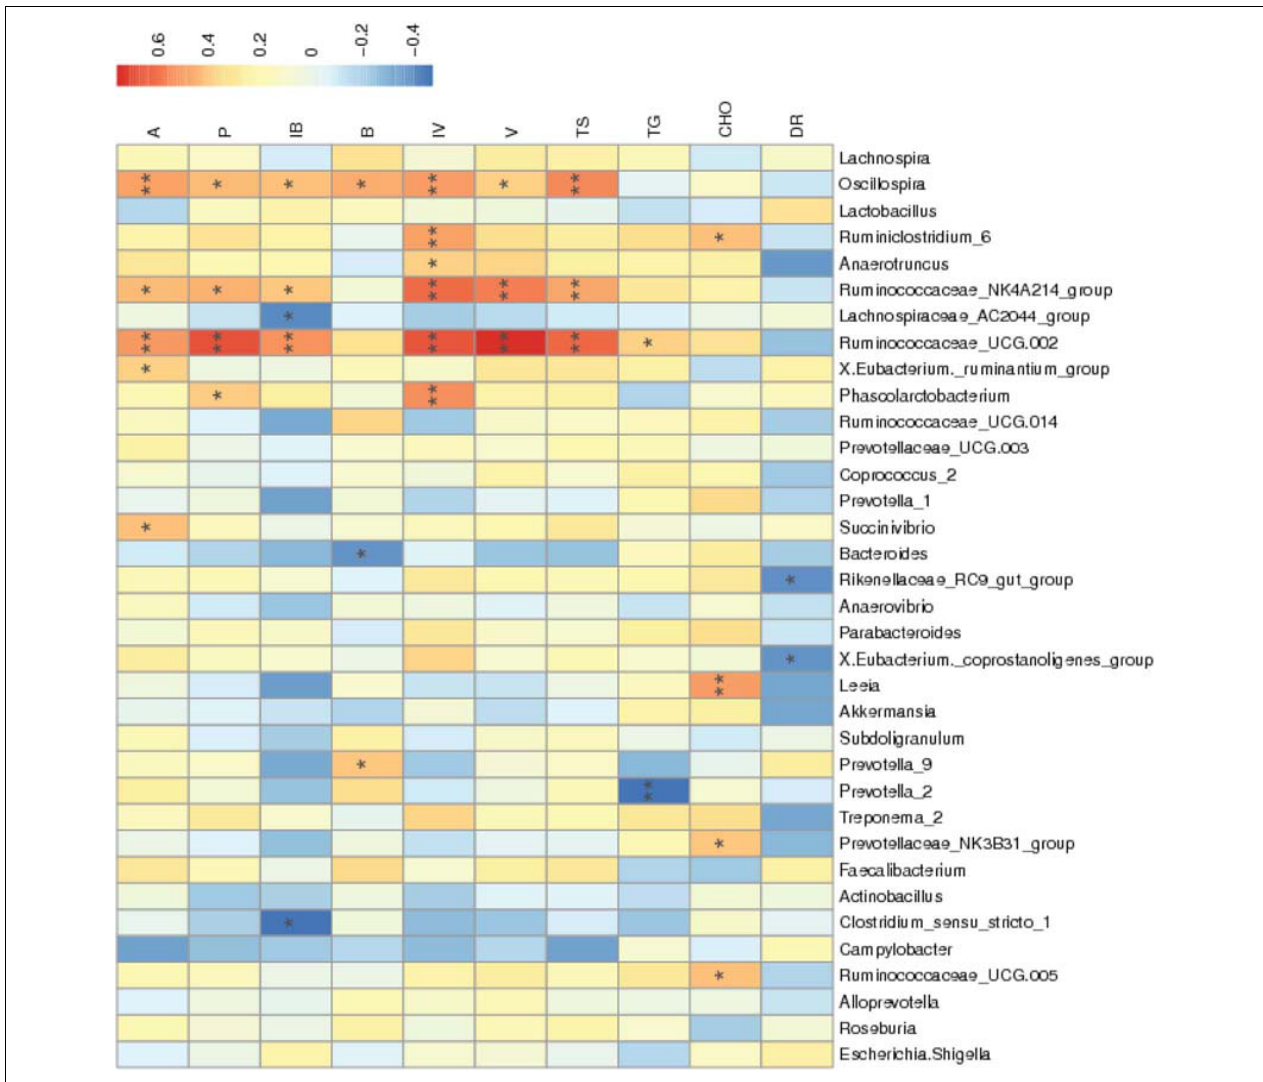
FIGURE 4 | Correlation of the environment and abundance of bacteria at the genus level. Species information is arranged in rows, and environment factors are arranged vertically and are on the horizontal axis ( x -axis). Different colors indicate the relative abundance between species and environment factors; r < 0 represented a negative correlation, and r > 0 represented a positive correlation. *Means P < 0.05. **Means P < 0.01. A, acetic acid; P, propionic acid; IB, isobutyric acid; B, butyric acid; IV, isovaleric acid; V, valeric acid; TS, total amount of SCFA; TG, triglyceride; CHO, cholesterol; DR, diarrhea rate during the third